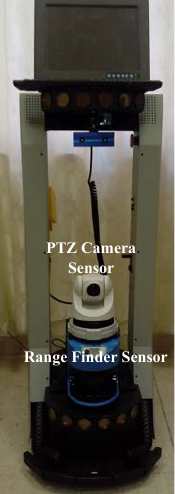
Figure 1. The PeopleBot mobile robot platform, where several sensors are attached to the robot, e.g., pan-tilt-zoom (PTZ) camera, laser range finder, sonars, stereo camera, etc.